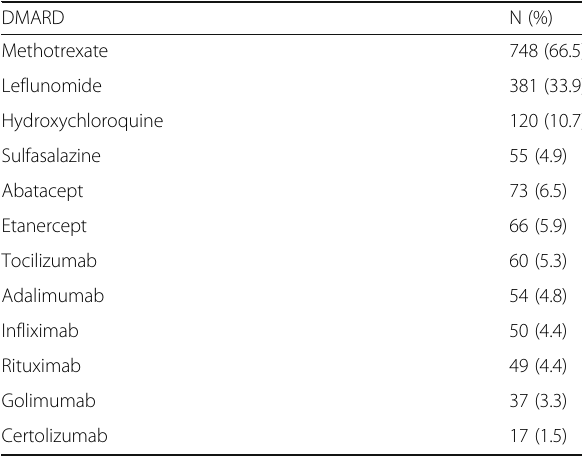
Table 5 Total frequencies of conventional synthetic and biological DMARDs in the REAL